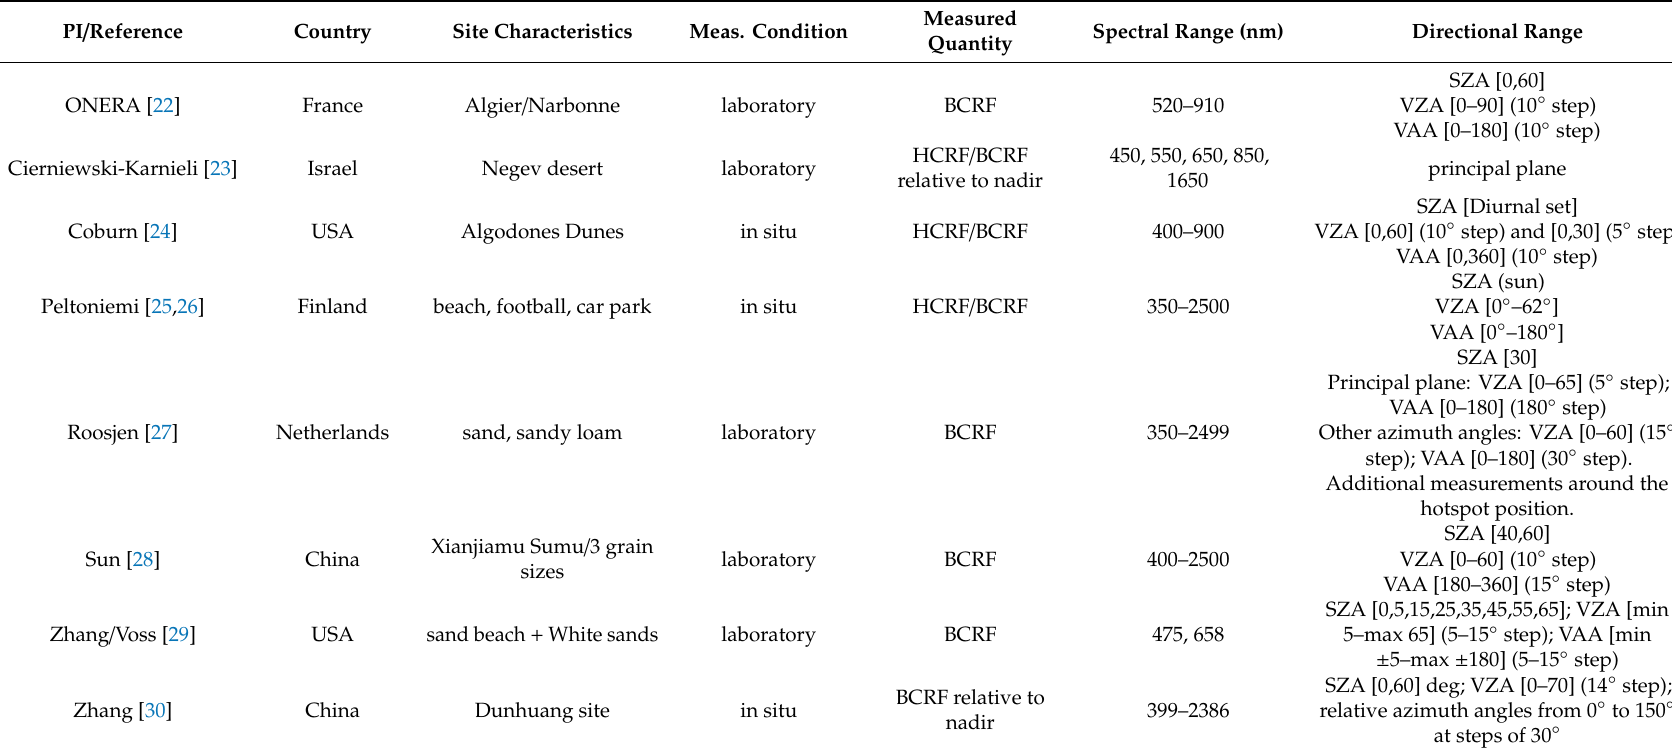
Table 6. Characteristics of the datasets with spectro-directional measurements. The measured quantities are either BCRF or HCRF (Hemispherical Conical Reflectance